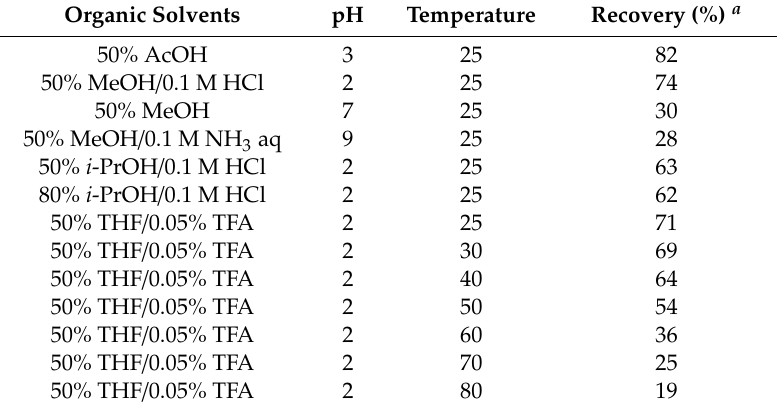
Table 1. Recoveries for the I 2 -oxidation of the Acm 2 -precursor peptide. Organic Solvents